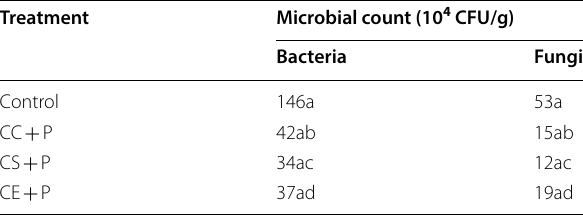
The same letters with in a column are significantly different (Tukey’s HSD p 0.05) and different letters with in a column are statistically insignificant ≤ different; Control, tomato plants treated with water only; CC P, plants treated + with Streptomyces sp. MR14 and pathogen; CS P, plants treated with MR14 + supernatant and pathogen; CE P, plants treated with MR14 solvent extract and + pathogen